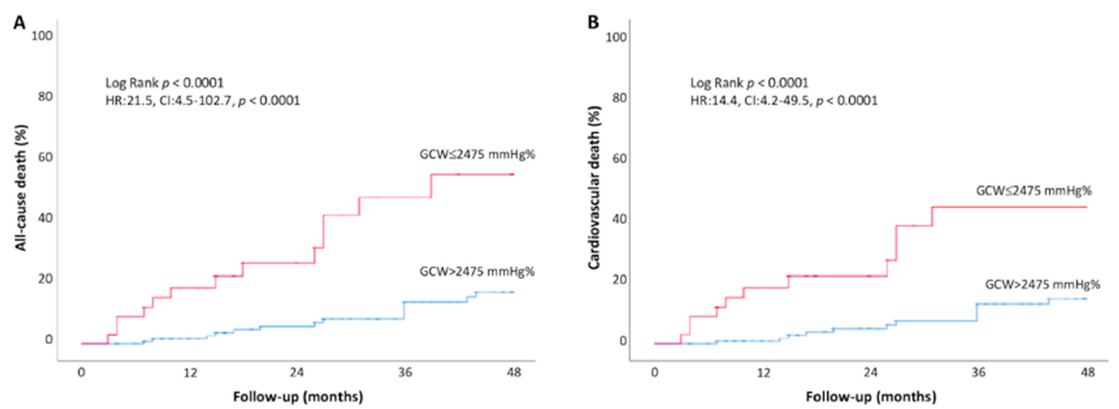
Figure 5. Kaplan–Meier curves of all cause ( A ) and cardiovascular death ( B ) during follow-up for asymptomatic AS patients according to baseline more impaired GCW ( ≤ 2475 mmHg%, blue line) vs. more preserved GCW (>2475 mmHg%, red line).